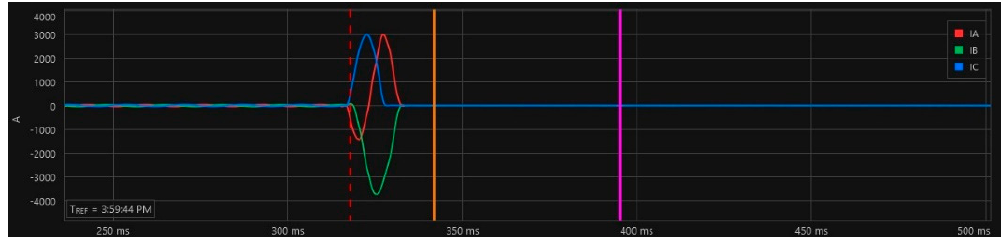
Figure 30. Phase currents recorded by R2 under instantaneous scheme.